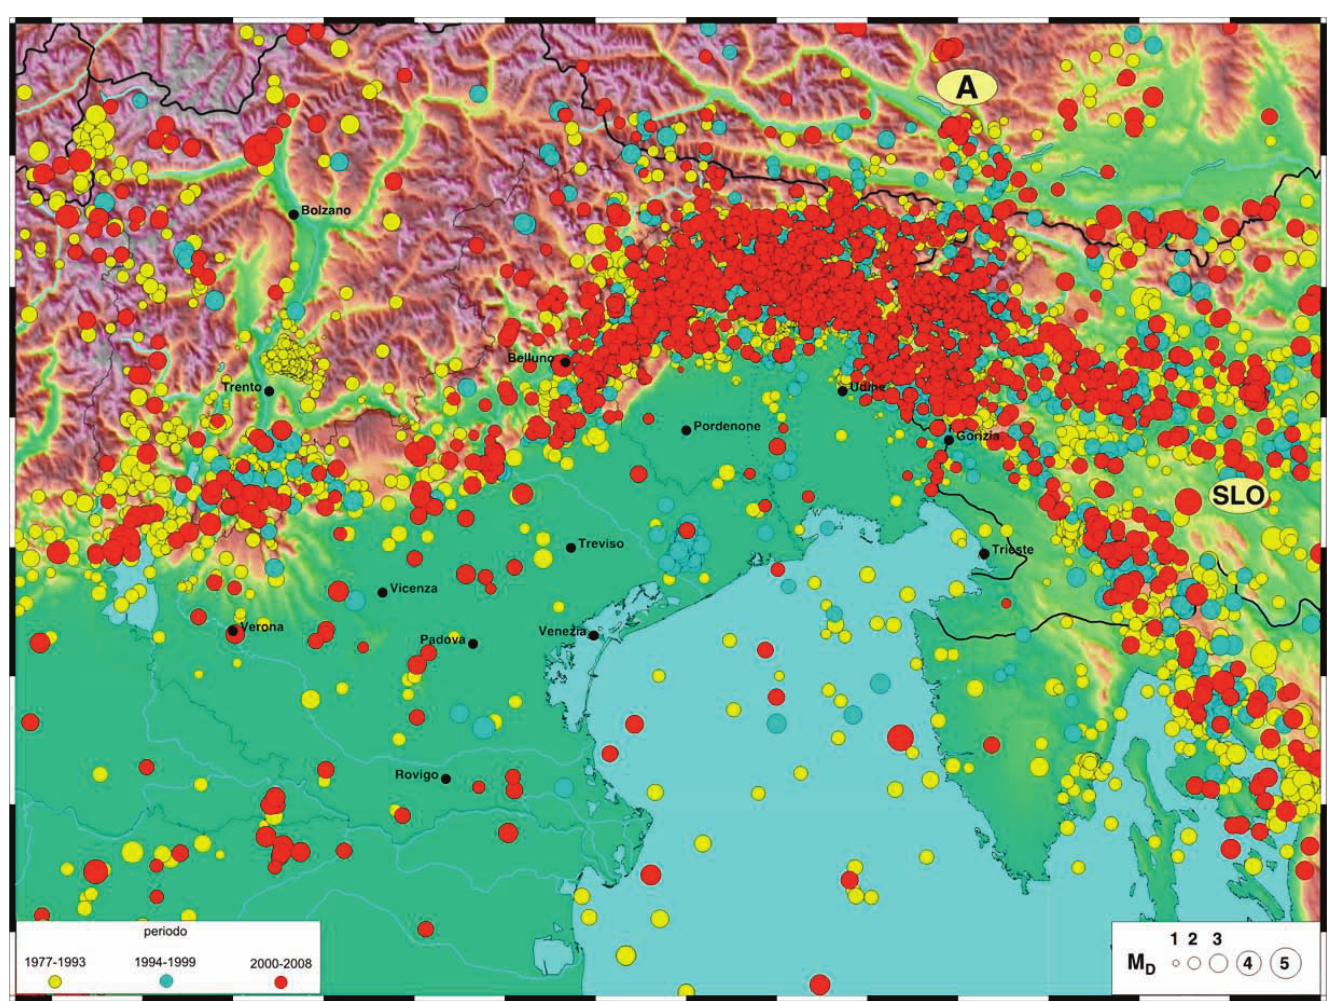
Figure 1. Seismicity of north-eastern Italy recorded at the OGS-CRS between 1977 and 2008 (courtesy of S. Urban). The 1976 Friuli earthquake, Ms = 6.5, is the largest recorded to date in the